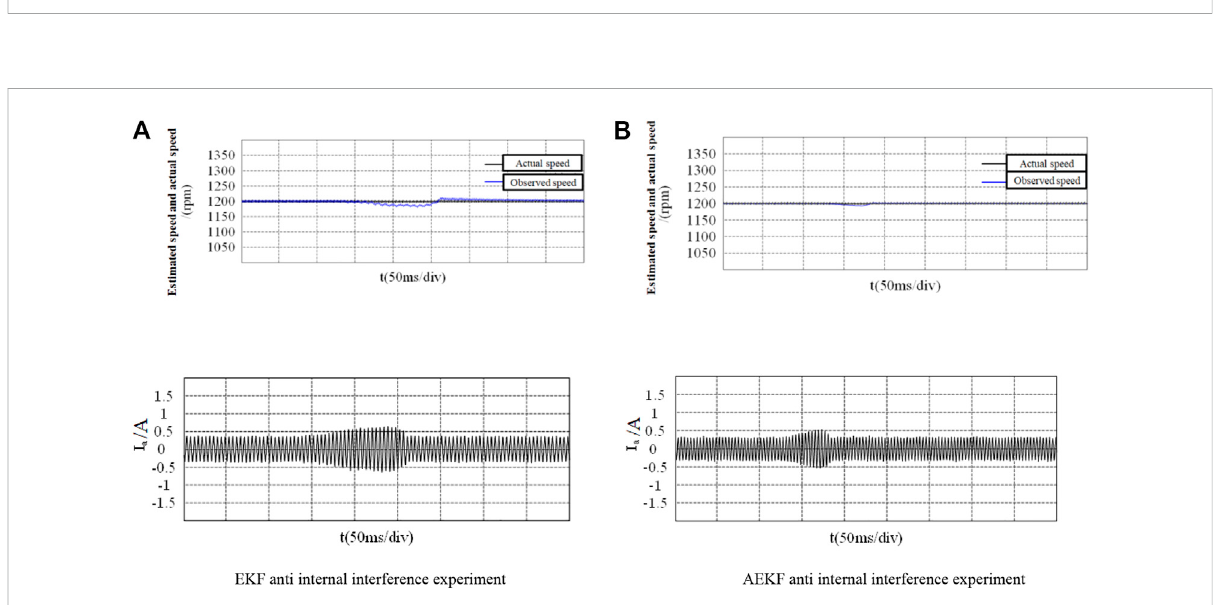
FIGURE 14 Rotor positionwaveform underexternal interference. (A) BasedonEKFrotor position. (B) BasedonAEKF rotorposition. (C) Rotor positionerror based on EKF. (D) Rotor position error based on